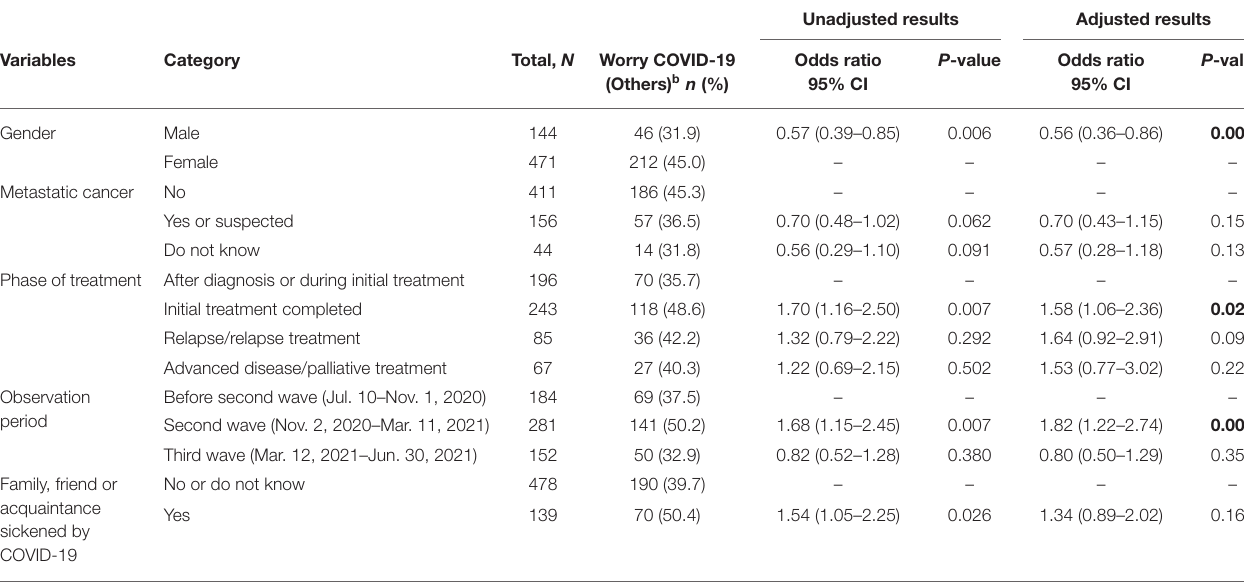
TABLE 4 | Logistic regression of associated factors for patient worry regarding relatives and friends being sickened or dying from COVID-19 a